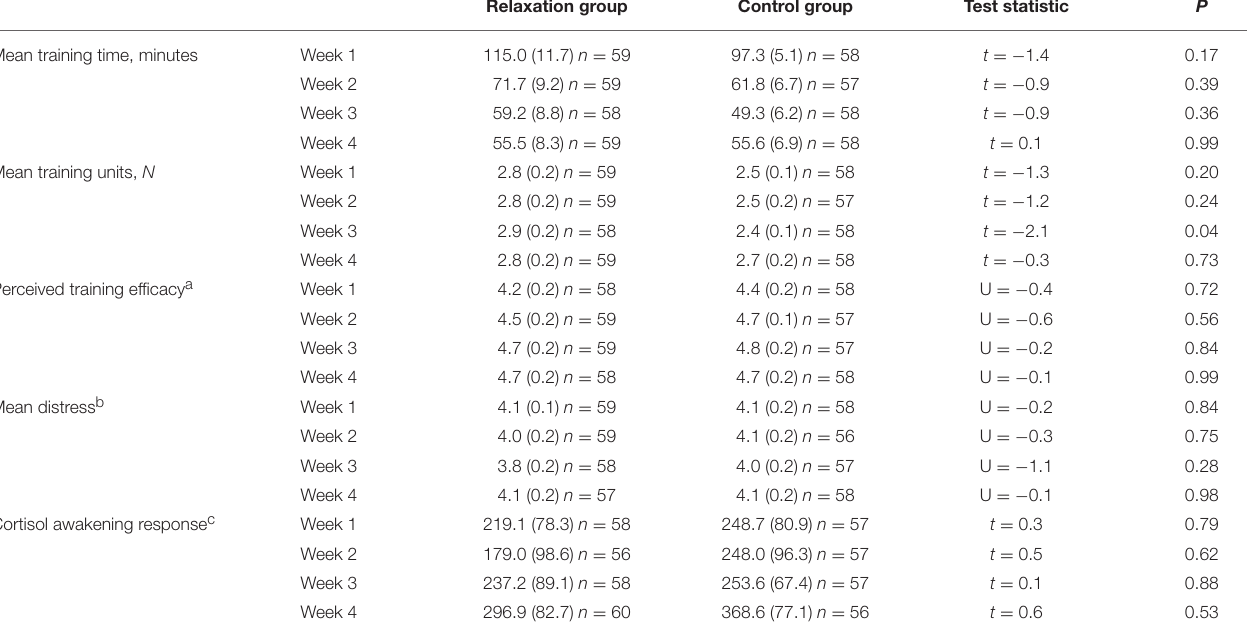
TABLE 2 | Relaxation training